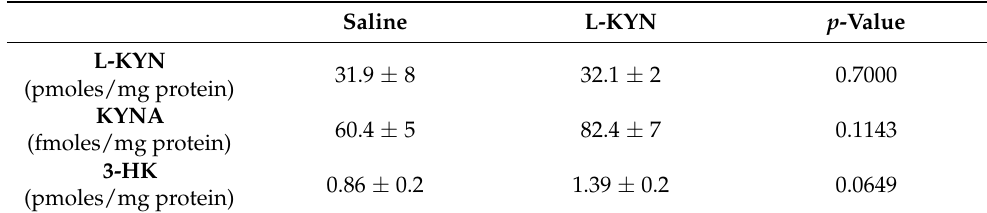
Table 4. Kynurenine metabolites brain levels.